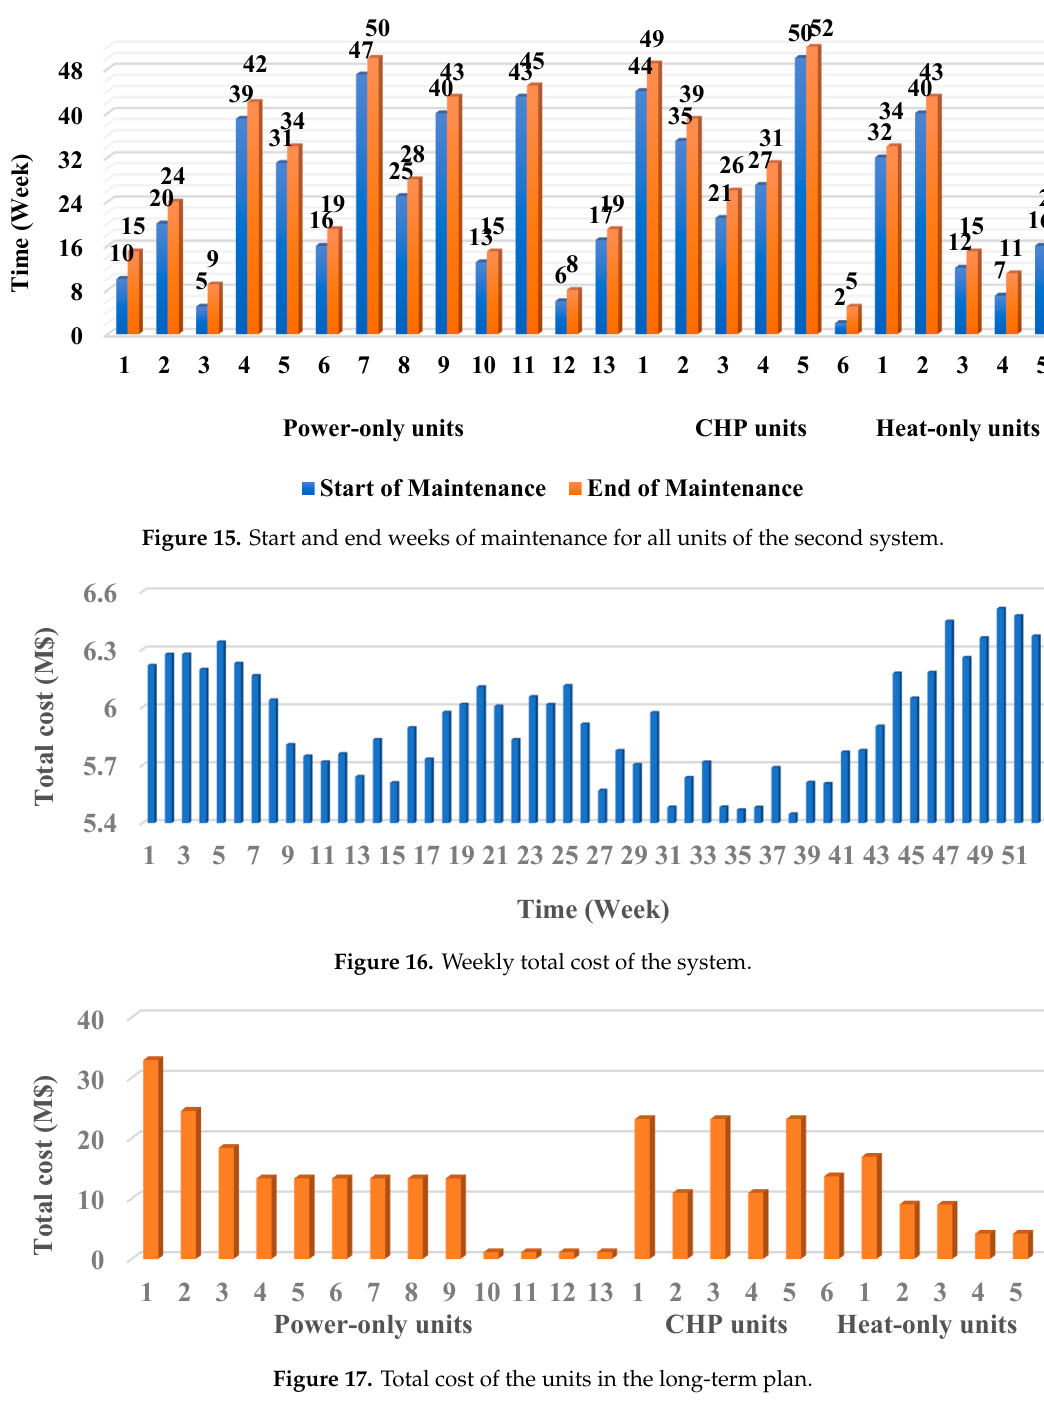
Figure 18. Total number of under-maintenance power-producing and heat-producing units respect to week.